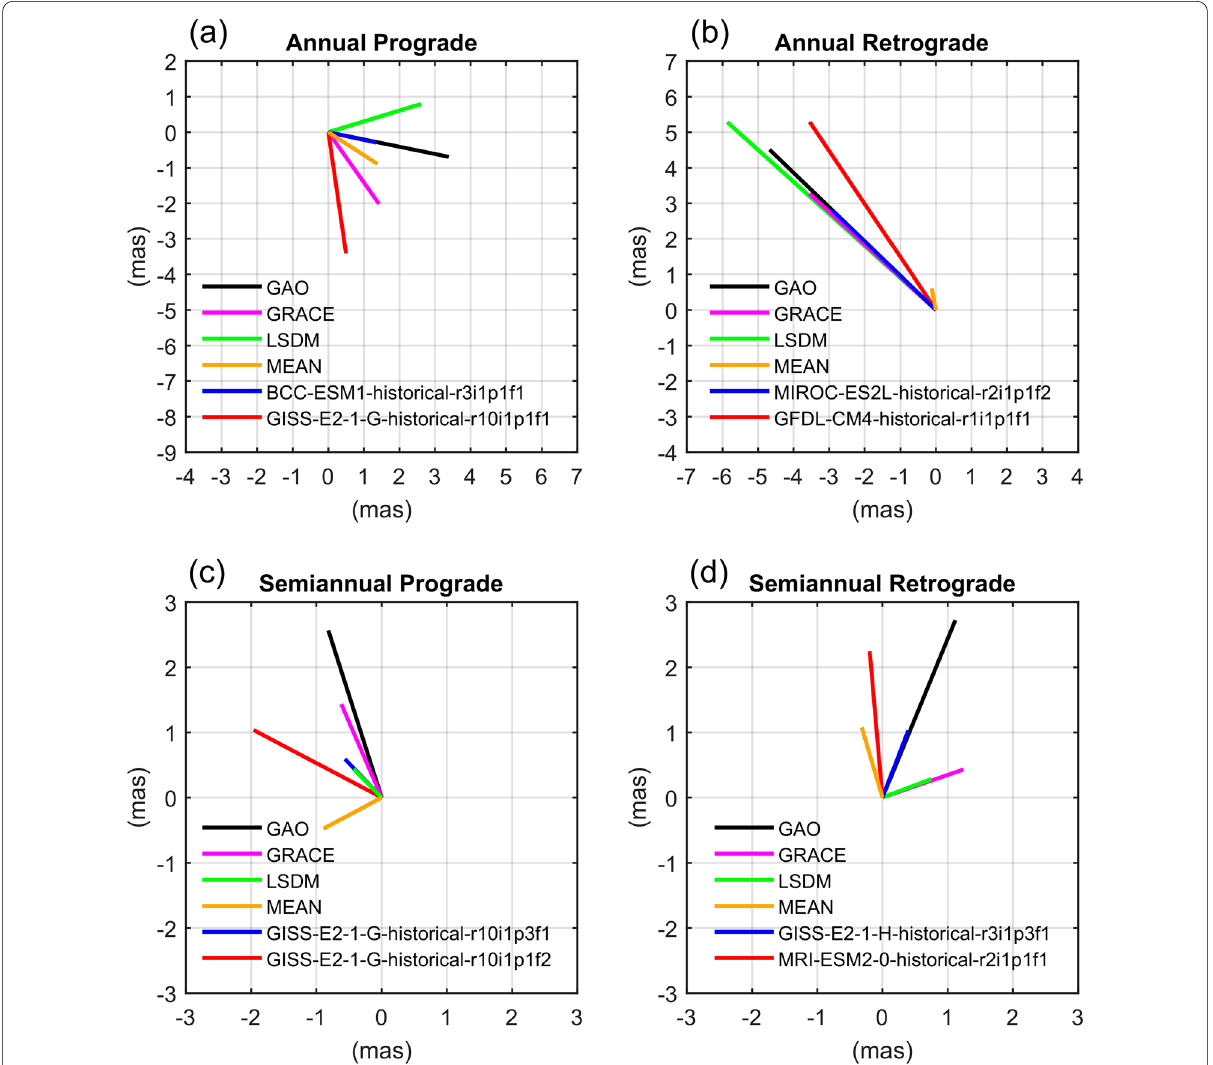
Fig. 8 Phasor diagrams of a annual prograde; b annual retrograde; c semiannual retrograde; and d semiannual retrograde oscillation in GAO and HAM computed from GRACE, LSDM, MEAN model and best fitted models selected from CMIP6 in terms of amplitude agreement (red vector) and phase agreement (blue